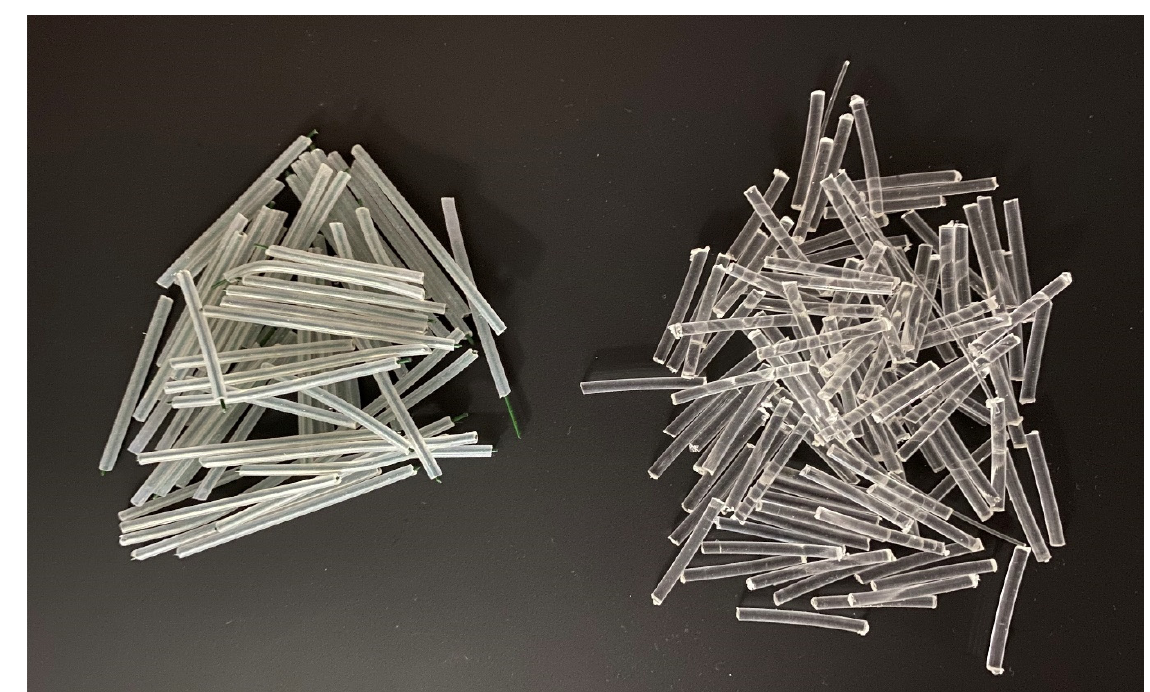
Figure 18. Plastic tubes with wires and plastic optical fibers (POF).